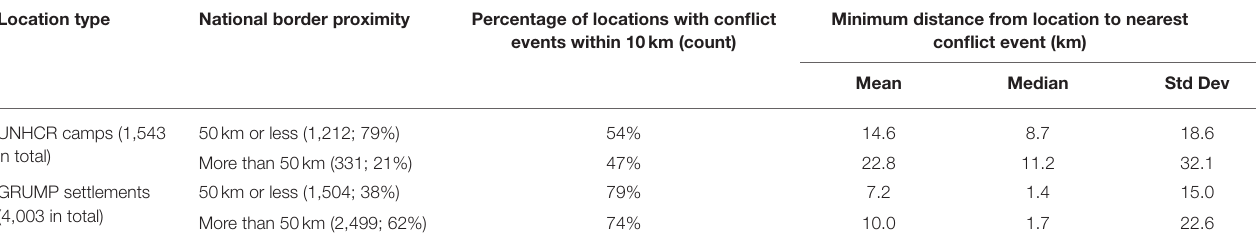
Std Dev is the standard